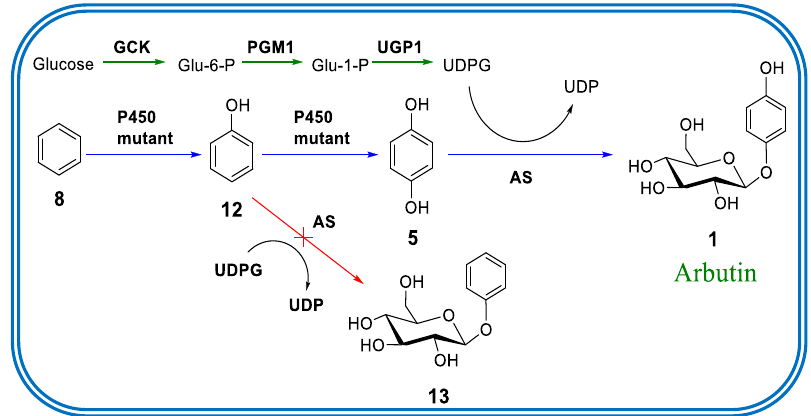
Figure 5. Biosynthesis of arbutin versus construction of the designed E. coli whole cell catalyst for the one-pot production of arbutin ( 1 ) starting from benzene ( 8 ) [36]. Green arrows: Natural endogeneous metabolic pathway; blue arrows: artificial pathway. P450 mutant: Engineered mutants of P450-BM3 A82F / A328F; GCK: Glucokinase; PGM1: Phosphoglucomutase; UGP1: UDP-glucose pyrophosphorylase; AS: Arbutin synthase. Figure adapted with permission from [36]. Copyright 2018 Wiley-VCH.